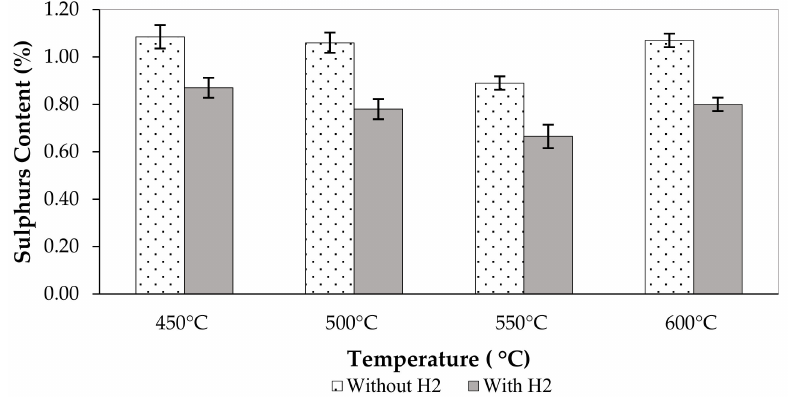
Figure 5. Sulphur content of the liquid fractions obtained at different temperatures with and without a constant flow of hydrogen.